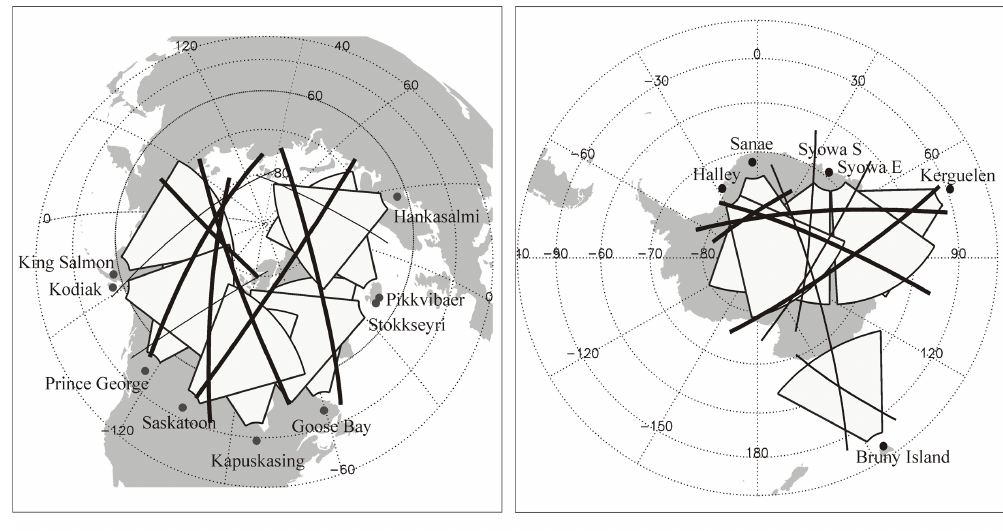
Fig. 1. SuperDARN radars’ field of views between 400 and 2800km in (a) Northern and (b) Southern Hemispheres and footprints (at a height of 300km) of DMSP F15 satellites. The trajectories represented by thick lines are potentially useful for cross-track ion drift velocity comparison with SuperDARN line-of-sight